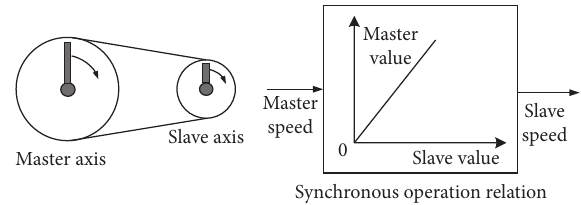
Figure 4: Electronic gear